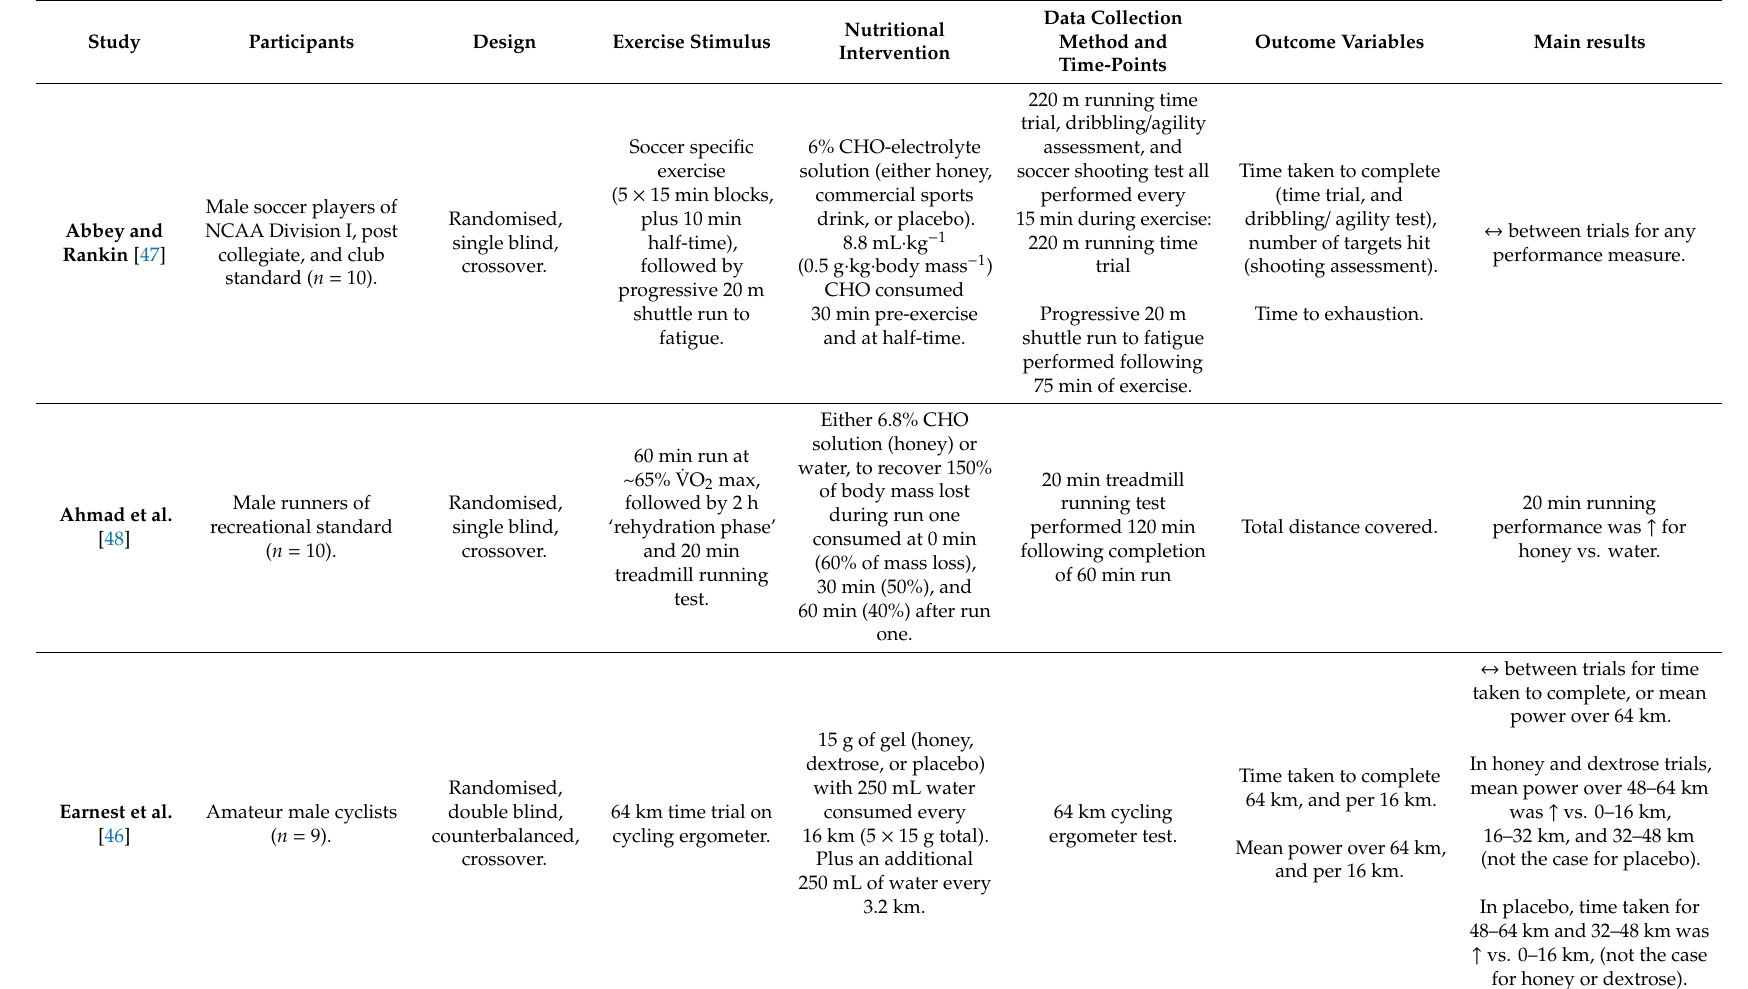
Table 3. Studies examining the e ff ect of honey supplementation on exercise (physical or skilled)